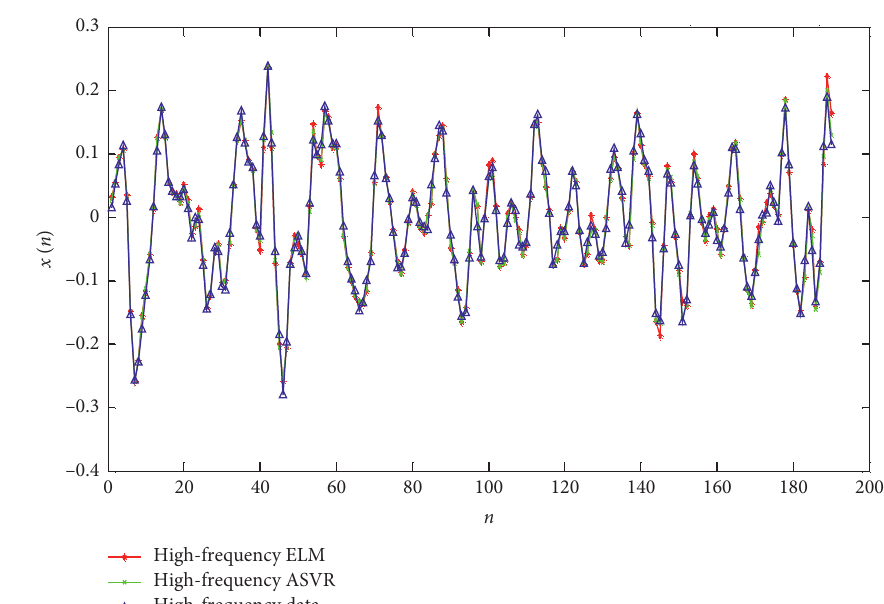
Figure 4: Forecasting results of high-frequency sequence of data set A by ELM and ASVR